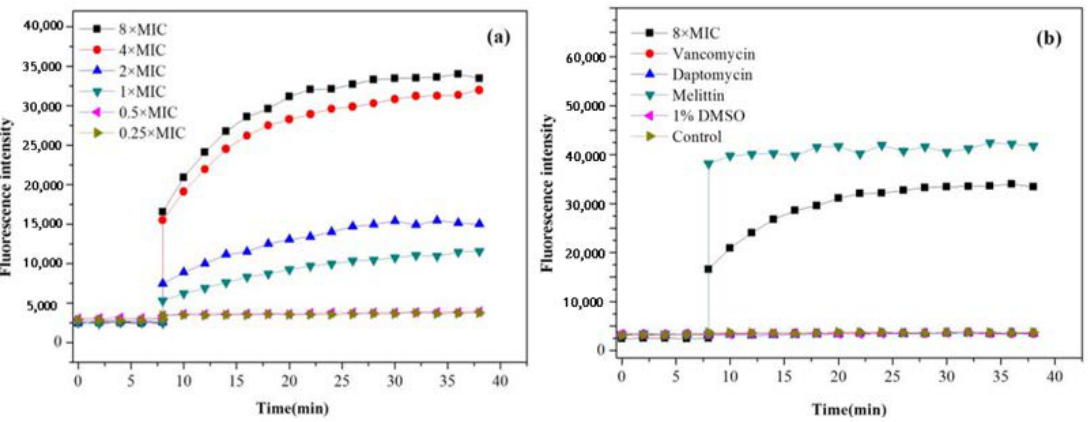
Figure 6. Mode of membrane disruption action of compound 7 . ( a ) Effects of compound 7 with different concentrations on the fluorescence intensity of SYTOX incubated with MRSA-3 at 1/4 × , 1/2 × , 1 × , 2 × , 4 × and 8 × MICs (MIC = 8 µ g/mL); ( b ) effects of different antibiotics on the SYTOX fluorescence intensity; vancomycin and daptomycin were used as the negative control, and melittin was used as the positive control. The data represent mean values of three independent experiments.